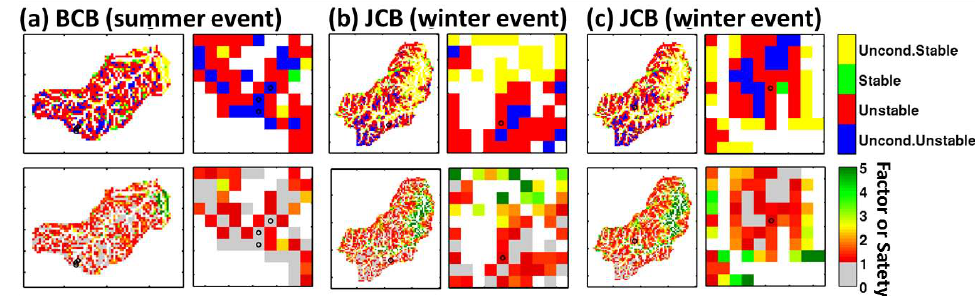
Fig. 14. The spatial distribution of slope stability characterized by the slope stability index (SSI, top), and the factor of safety (FS, bottom) at the time the debris flow occurred in the basins during the event in July of 2011 (a) , and in January (b) and December (c) of 2009. The debris flow locations are marked by circles. The right-hand side panels are spatial zooms into the initiation zone.